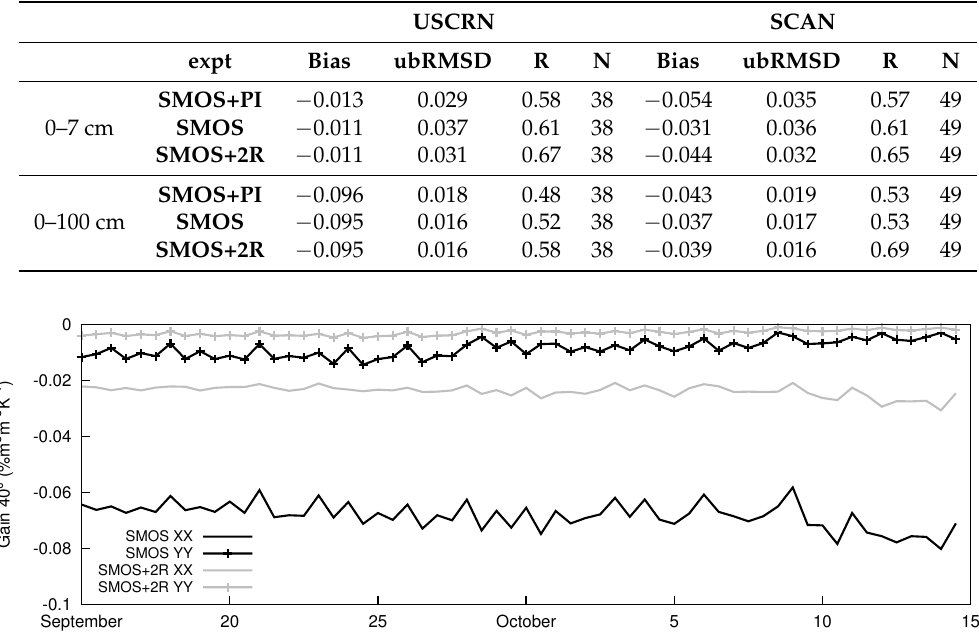
Table 3. The same as Table 2 but the experiment types in this table assimilate only SMOS T B with different weight given to the observations: SMOS+PI (soil moisture analysis are a direct projection of SMOS T B observation in the state space), SMOS (with the specific radiometric accuracy as the observation error) and SMOS+2R (doubling the error of the SMOS observations in the SEKF). Note that for all this group of experiments the B matrix is static.